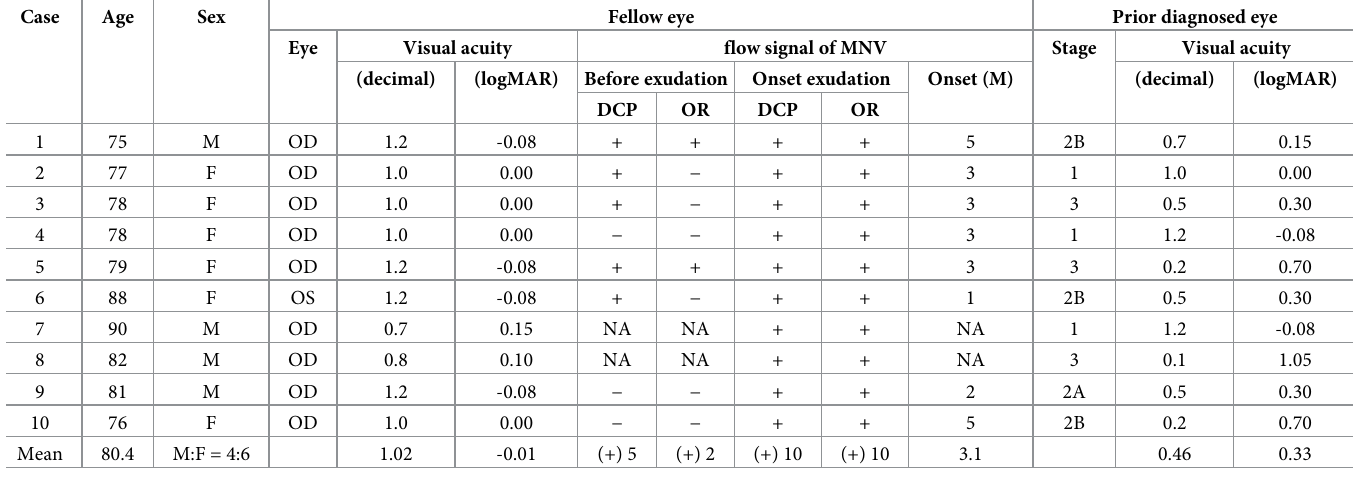
Table 1. Characteristics of eyes with prior diagnosed and fellow eyes of all